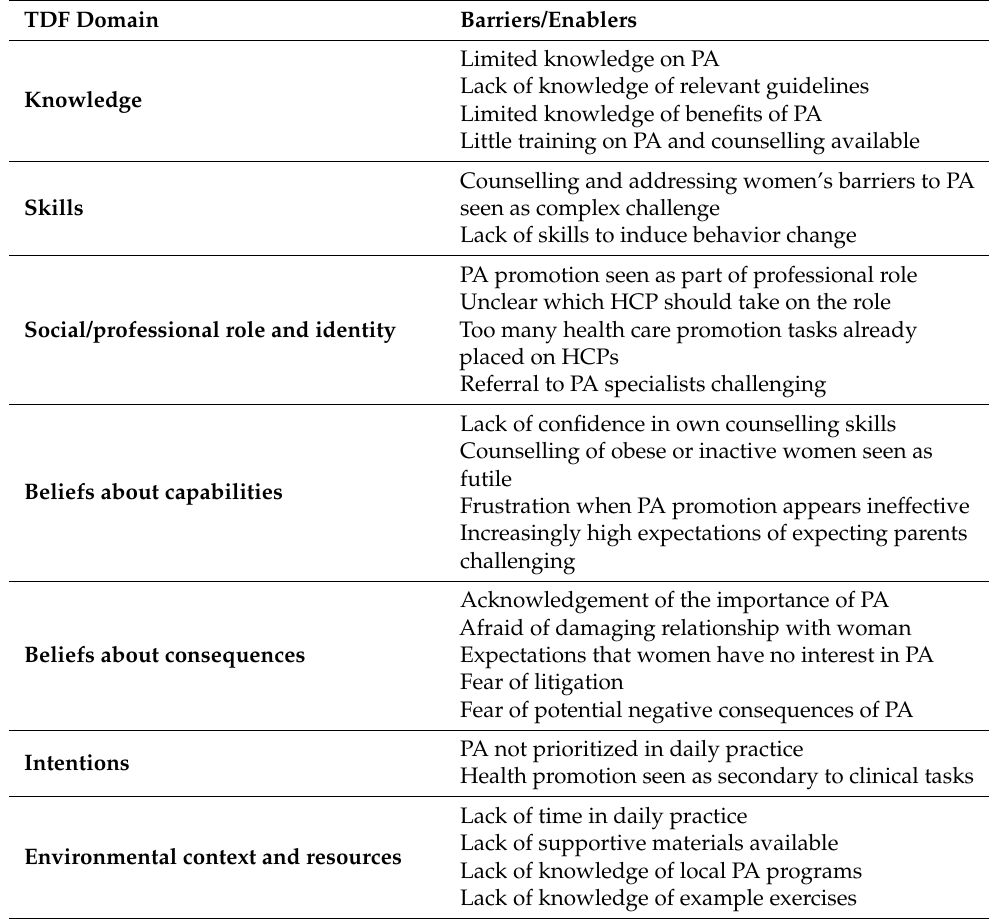
Table 1. Summary of HCP barriers and enablers of PA promotion, sorted by TDF